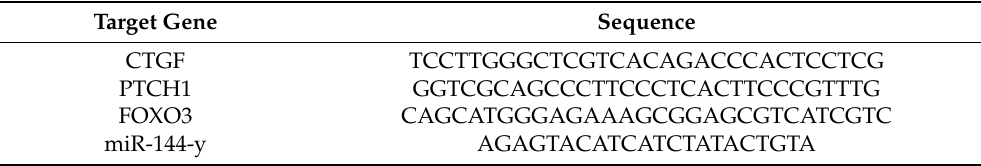
Table 2. Probe sequence for in situ